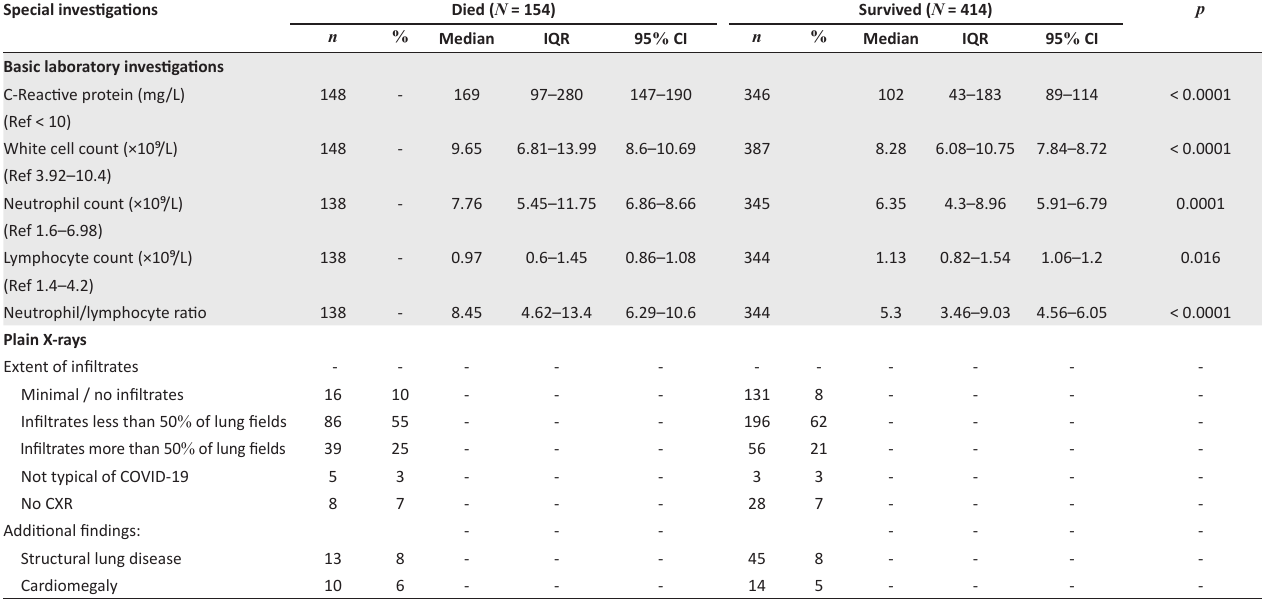
TABLE 2: Comparison of special investigations: Baseline basic laboratory results and plain CXR (describing extent of infiltrates and additional findings) in patients who survived and died of COVID-19. Special investigations